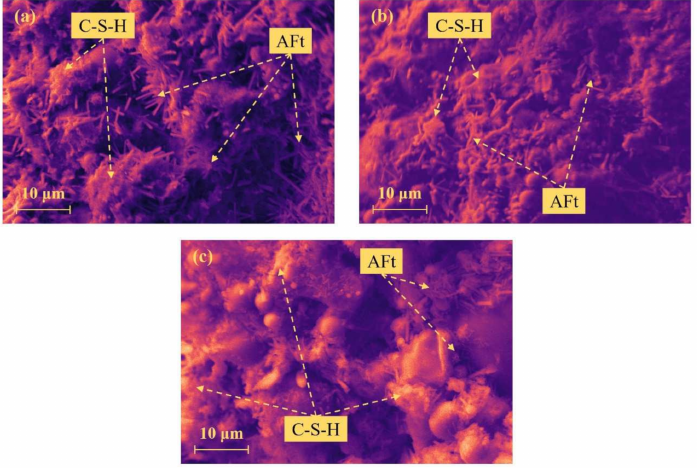
Figure 10. SEM images of CBC samples with different cement content. ( a ) No cement; ( b ) 1:12; ( c )